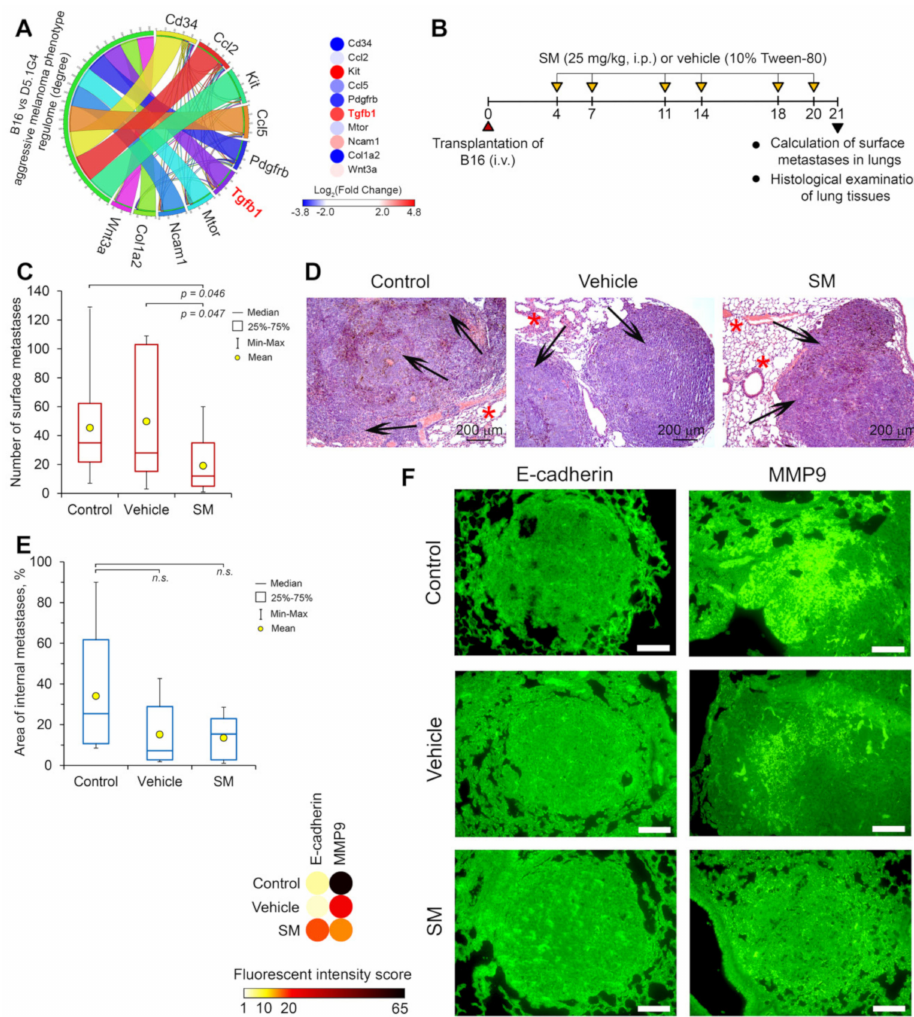
Figure 8. SM suppresses the metastatic growth of B16 melanoma in vivo. ( A ) TGF- β plays a key role in regulation of high tumorigenicity of B16 melanoma cells. The whole genome expression profiles of highly aggressive B16 and poorly tumorigenic D5.1G4 murine melanoma cells were compared by re-analysis of GSE69908 dataset using GEO2R tool. The left panel shows the top 10 master regulators, which control the growth and metastasis of B16 melanoma and are the most associated with analyzed regulome. Degree—the number of interconnections between master regulators and neighbors in gene regulatory network reconstructed from obtained di ff erentially expressed genes ( | Log 2 (Fold Change) |> 2, p < 0.05) using the Search Tool for the Retrieval of Interacting Genes (STRING) database. The right panel shows the changing of expression of revealed master regulators between B16 and D5.1G4 cells (red and blue represent up- and down-regulation, respectively). ( B ) The scheme of the animal study. ( C ) The number of surface metastases in the lungs of B16 melanoma-bearing mice. ( D , E ) Histological images ( D ) and areas of internal metastases ( E ) of B16 melanoma in the lungs of tumor-bearing mice without treatment and after SM or vehicle administration. Hematoxylin and eosin staining. Original magnification × 100. The black arrows and red asterisks indicate lung metastasis foci and normal lung tissue, respectively. ( F ) SM suppresses the expression of EMT-associated markers on the model of B16 melanoma in vivo. Representative images of immunohistochemical staining of lung metastases with anti-E-cadherin and anti-MMP9 primary antibodies with subsequent incubation with secondary Alexa Fluor ® 488-conjugated antibodies. Scale bar corresponds to magnification × 200. The intensity of green fluorescence, corresponding to the expression of E-cadherin and MMP-9, was calculated according to the formula (2) for each image after subtraction of background using ImageJ software and visualized as a heatmap using Morpheus